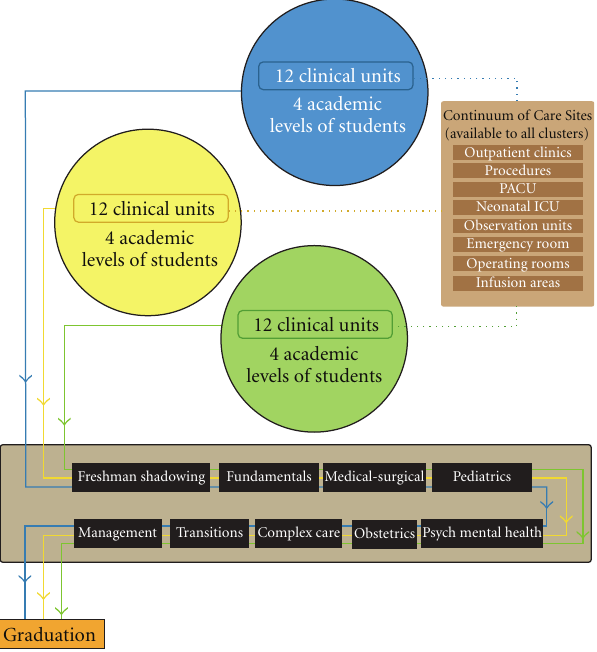
Figure 1: Clinical clusters, continuum of care, undergraduate clinical